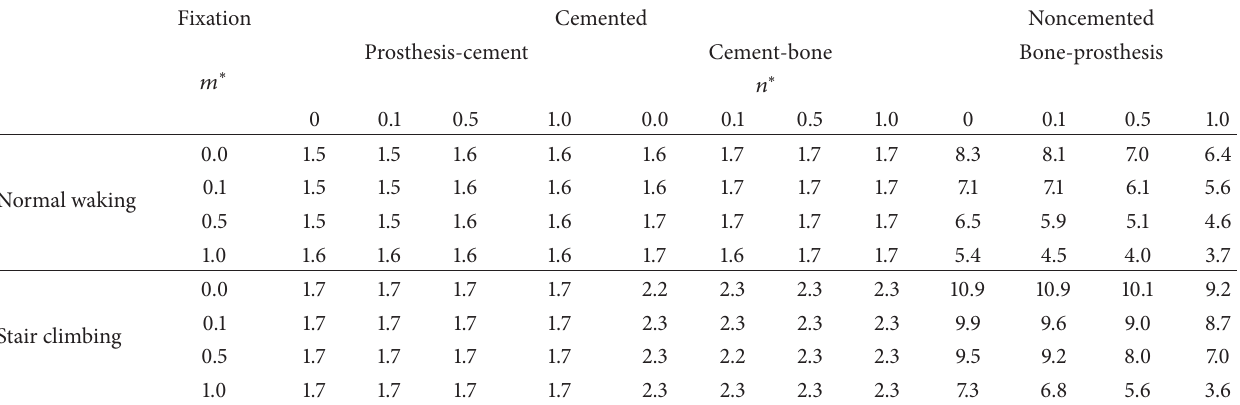
∗ 𝑛 : radial volume fraction gradient exponent. ∗ 𝑚 : longitudinal volume fraction gradient